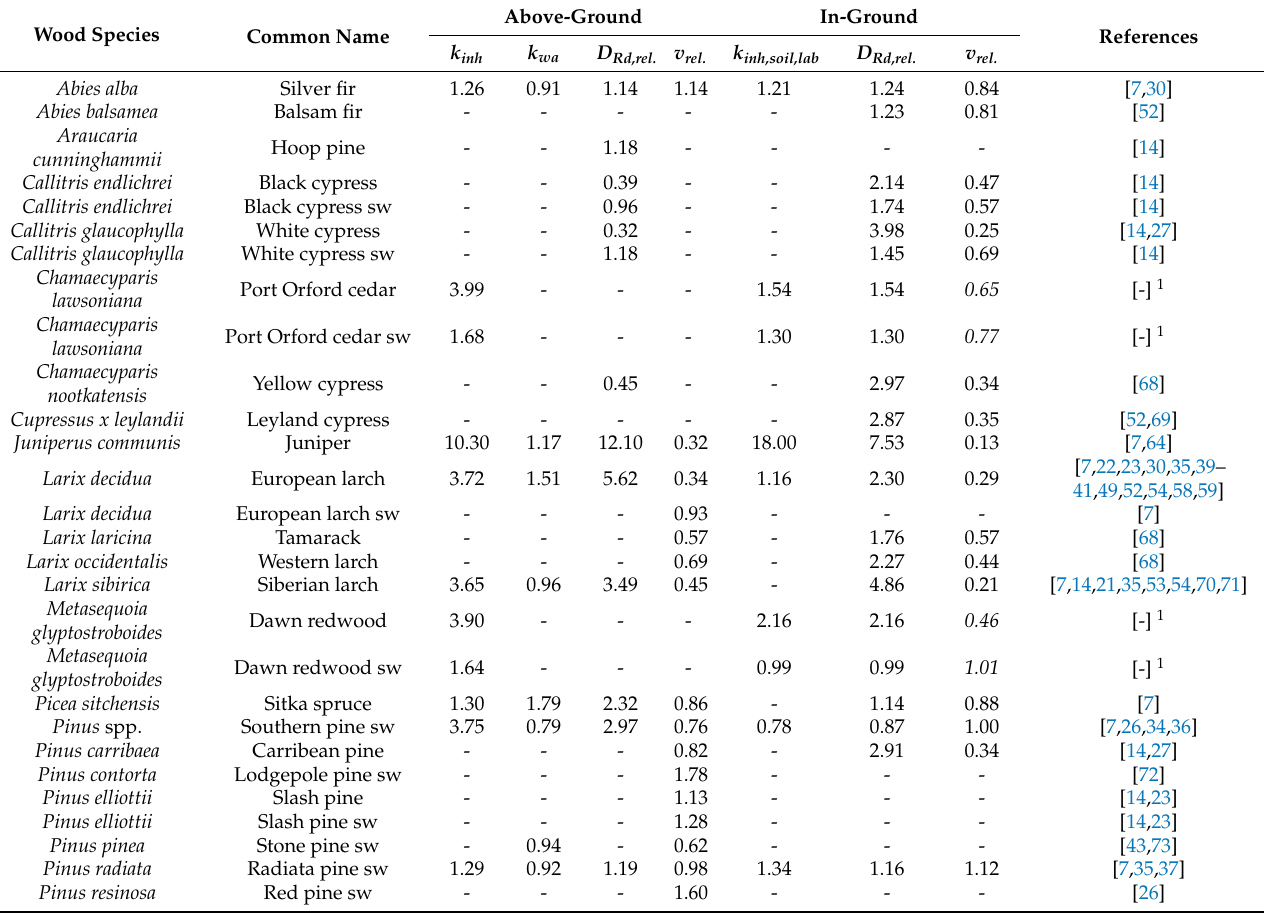
Table 2. Parameters for predicting the material resistance of untreated softwoods in- and above-ground. k inh = factor accounting for protective inherent properties based on white rot, brown rot, and soil contact tests; k inh,soil,lab = factor account- ing for protective inherent properties based on laboratory test with soil contact and soft rot fungi; k wa = factor accounting for moisture performance (wetting ability); D Rd,rel. = relative resistance dose; v rel. = relative decay rate; sw = sapwood. Calculated v rel. in